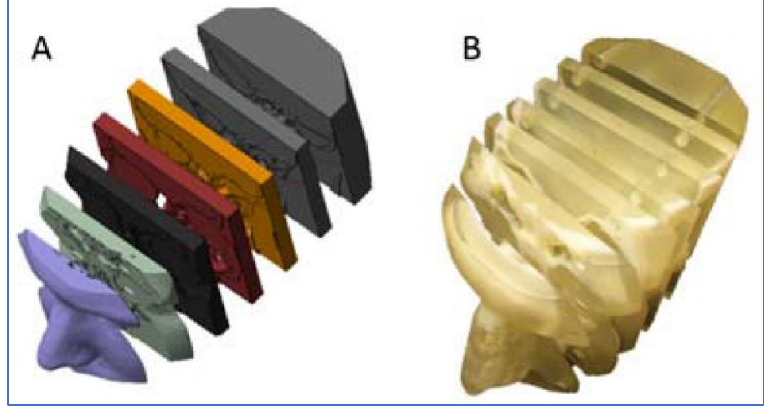
Figure 4. ( A ) CT scan slices of patient nasal cavity, ( B ) MJ printed model [102].